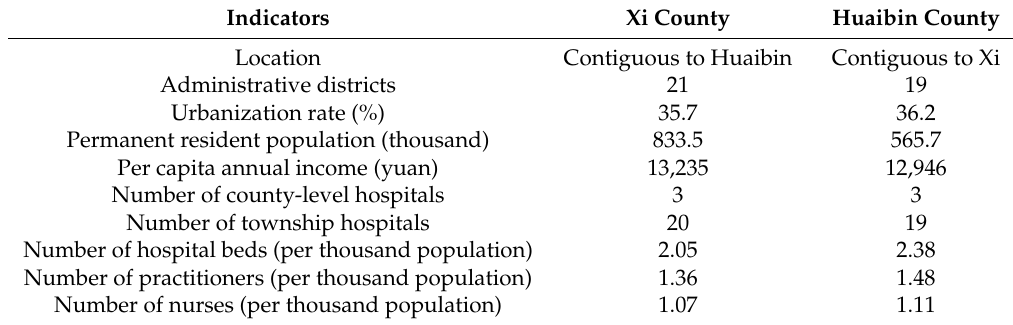
Figure 1. Locations of the Xi and Huaibin Counties in China and the Henan Province. Table 1. Socioeconomic Indicators of Xi and Huaibin Counties in